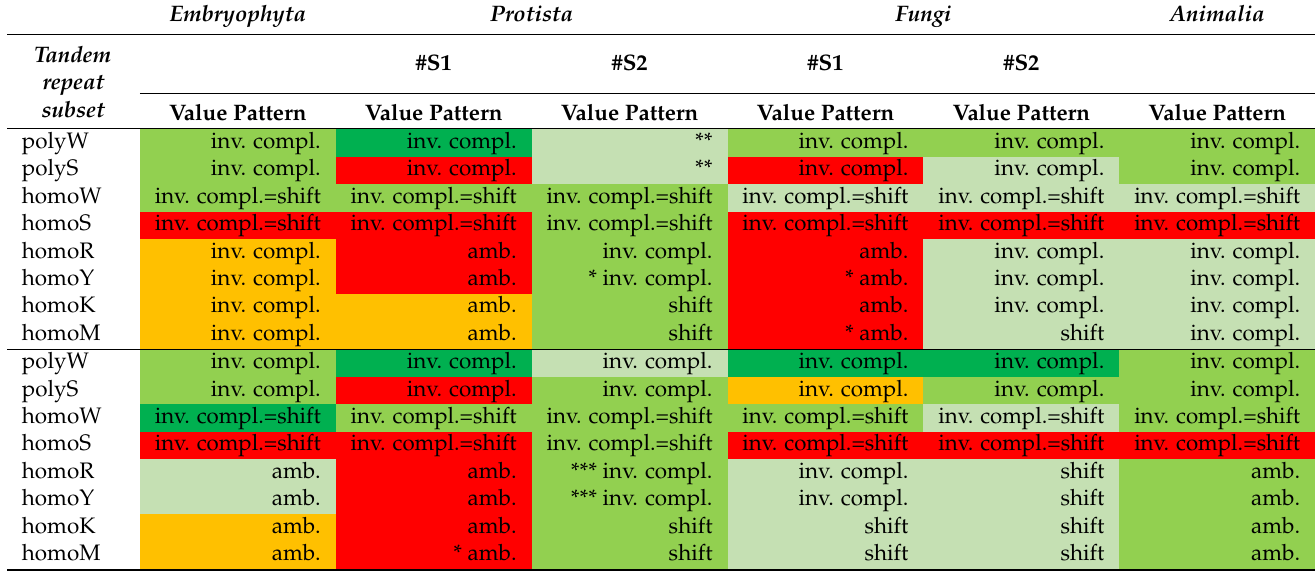
Table 5. Patterns in value distribution of correlation contributions for k = 7 (top) and k = 11 (bottom). Descriptions are given on how the subsets of sequences behave. PolyW is either polyA or polyT, polyS is either polyC or polyG and all other sequences are tandem repeats with a repeat unit length of b = 2 with W = {A;T}, S = {C;G}, R = {A;G}, Y = {C;T}, K = {G;T} and M = {A;C}. The entries for the value patterns are “inv. compl.” if the close value is in an inverse complementary sequence (for ACACACA this would be TGTGTGT), “shift” if the close value is in a sequence with a shift (for ACACACA this would be CACACAC) and “amb.” if it seems ambiguous between “inv. compl.” and “shift” as all possible values are close to each other. The values of correlation contributions are color-coded, with dark green if both values are above 0.1; light green if both values are above 0.01 up to 0.1; bright green if both values are above 0.001 and up to 0.01; orange if both values are above 0.0001 and up to 0.001; and red if both values are up to 0.0001. * One of the two values slightly in adjacent interval;